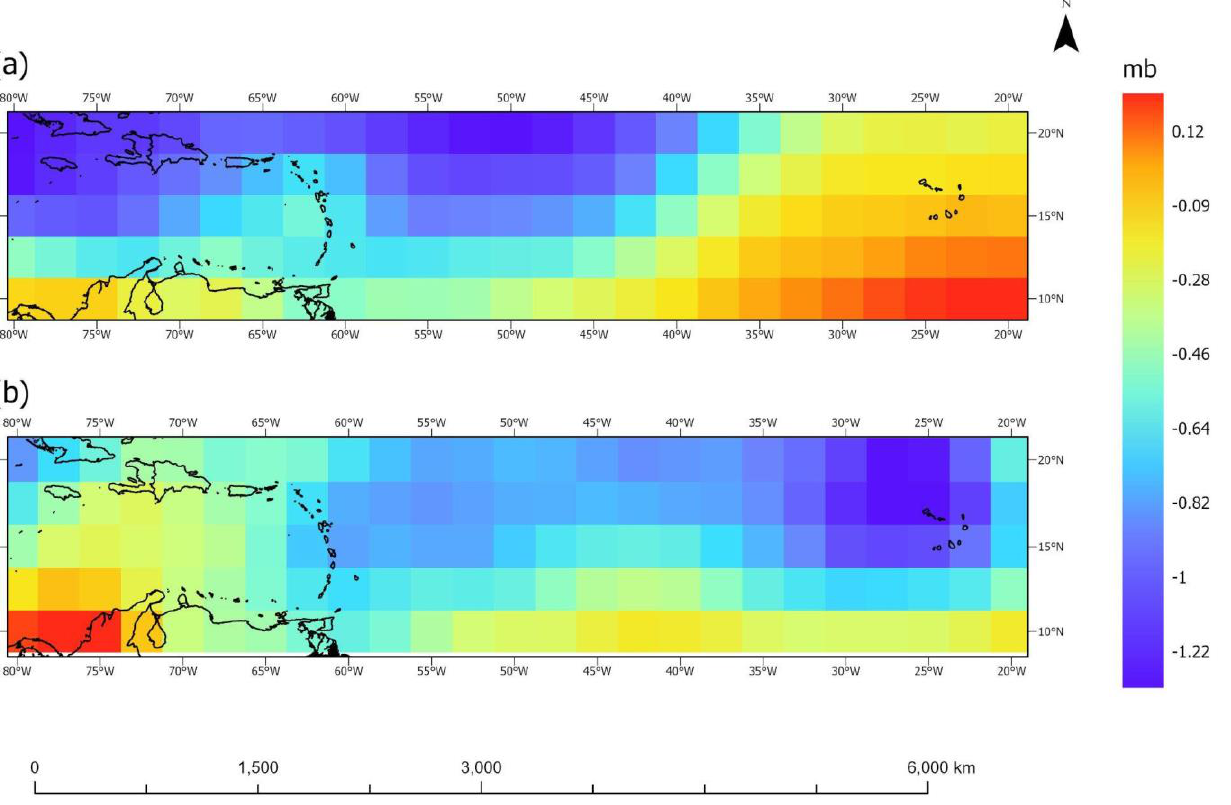
Figure 6. Sea level pressure (SLP) composite anomalies in the NA basin for the 2005 ( a ) and 2020 ( b ) hurricane seasons (June –